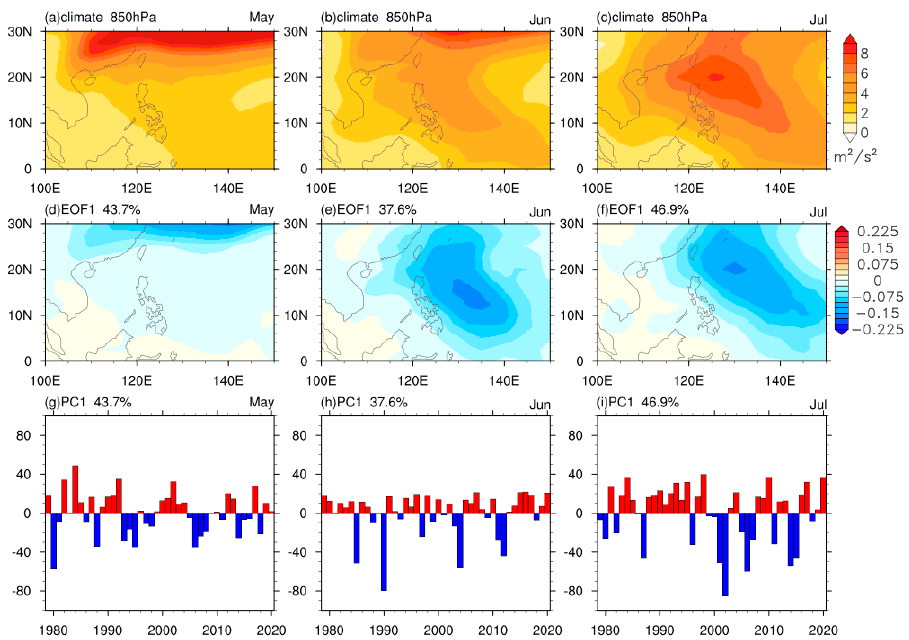
Figure 1. Variation in monthly EKE in the SCS-PS. Climatological mean (1979 − 2020) of EKE at 850 hPa in: ( a ) May; ( b ) June; and ( c ) July; ( d – f ) EOF1s of monthly EKE at 850 hPa in the SCS-PS; ( g – i ) time series of EOF1s.